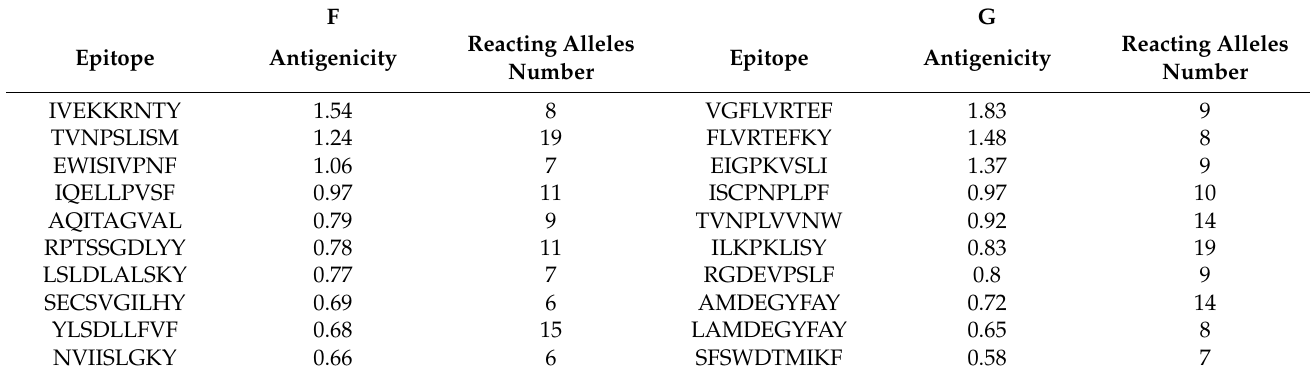
Table 3. Top-ranked T cell epitopes (MHC-I peptides) of F and G proteins.